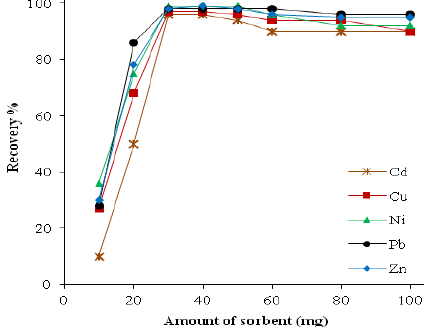
Figure 3. Effect of amount of sorbent on metal ions adsorption. Other conditions: pH 5.0, temperature 25  C, shaking time 30 min, sample volume 10